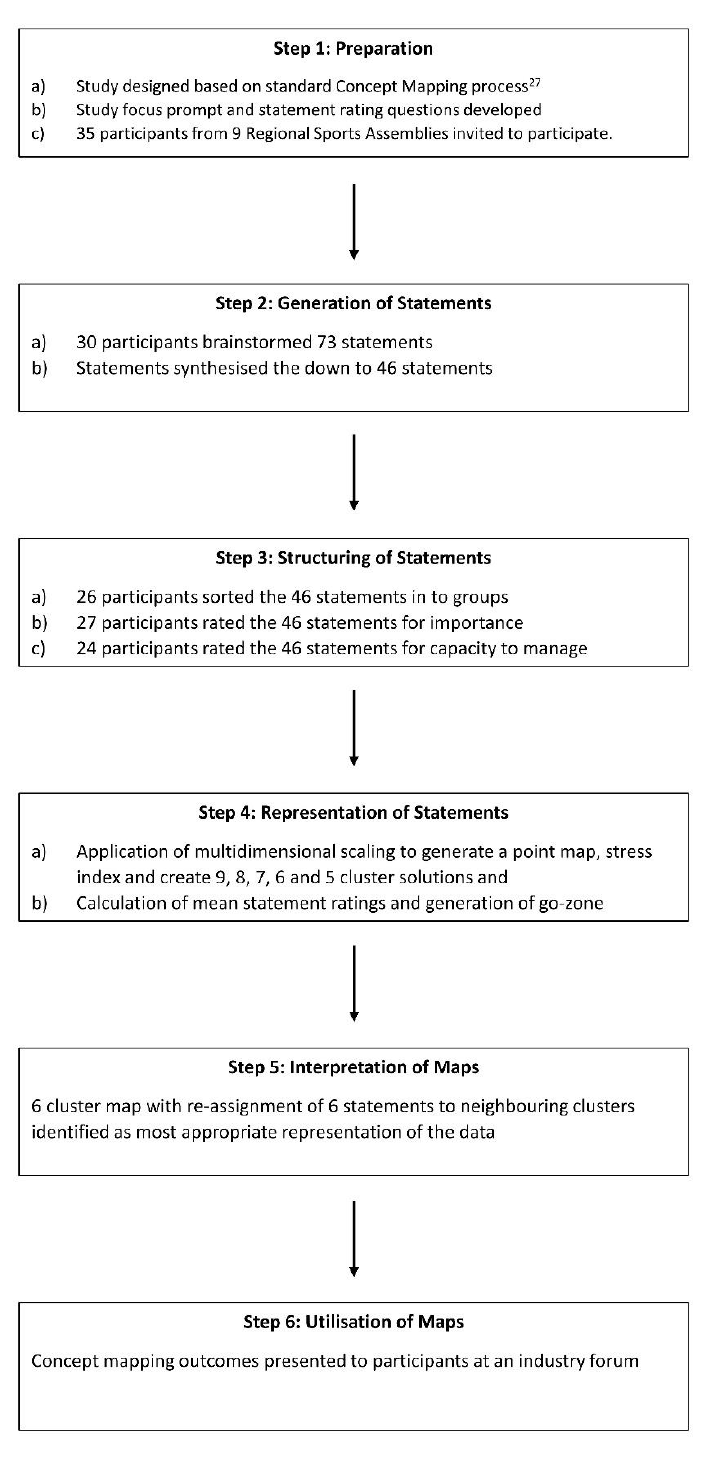
Figure 2. Flow of concept mapping process for this study.